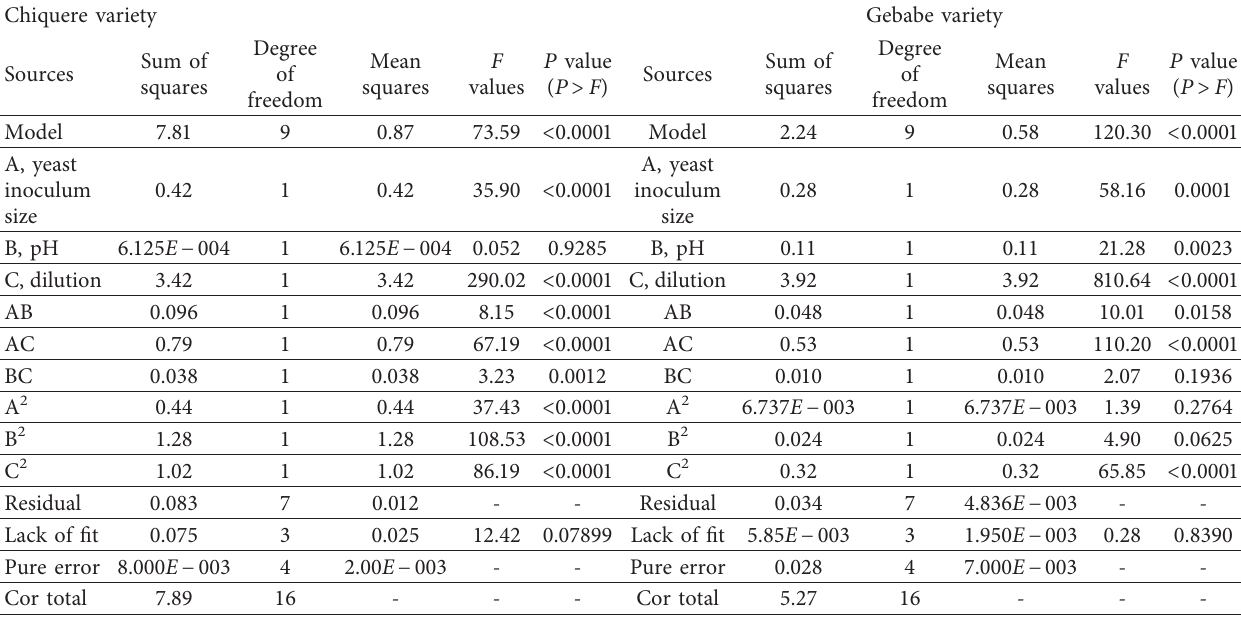
Table 4: Analysis of variance (ANOVA) of Chiquere and Gebabe variety ethanol yield of sweet sorghum. Chiquere